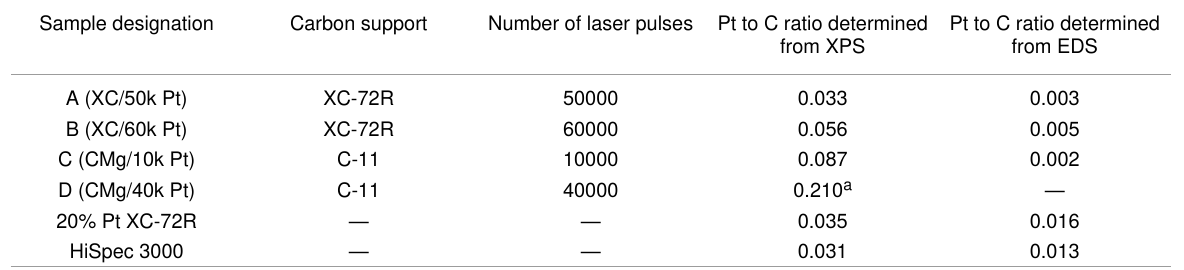
Table 1: Characteristics of catalysts obtained by the PLD deposition of platinum on carbon